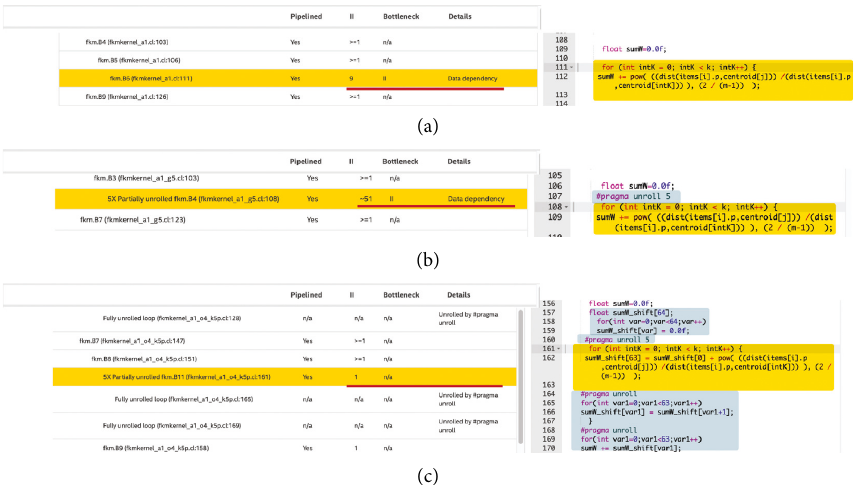
Figure 5: Using optimization techniques in a significant part of code. (a) Unoptimized loop. (b) Using loop unrolling. (c) Using Loop unrolling, shift register, and local memory. FCM clustering sample output for A1 dataset with K=20, and Centers are labeled in blue colour